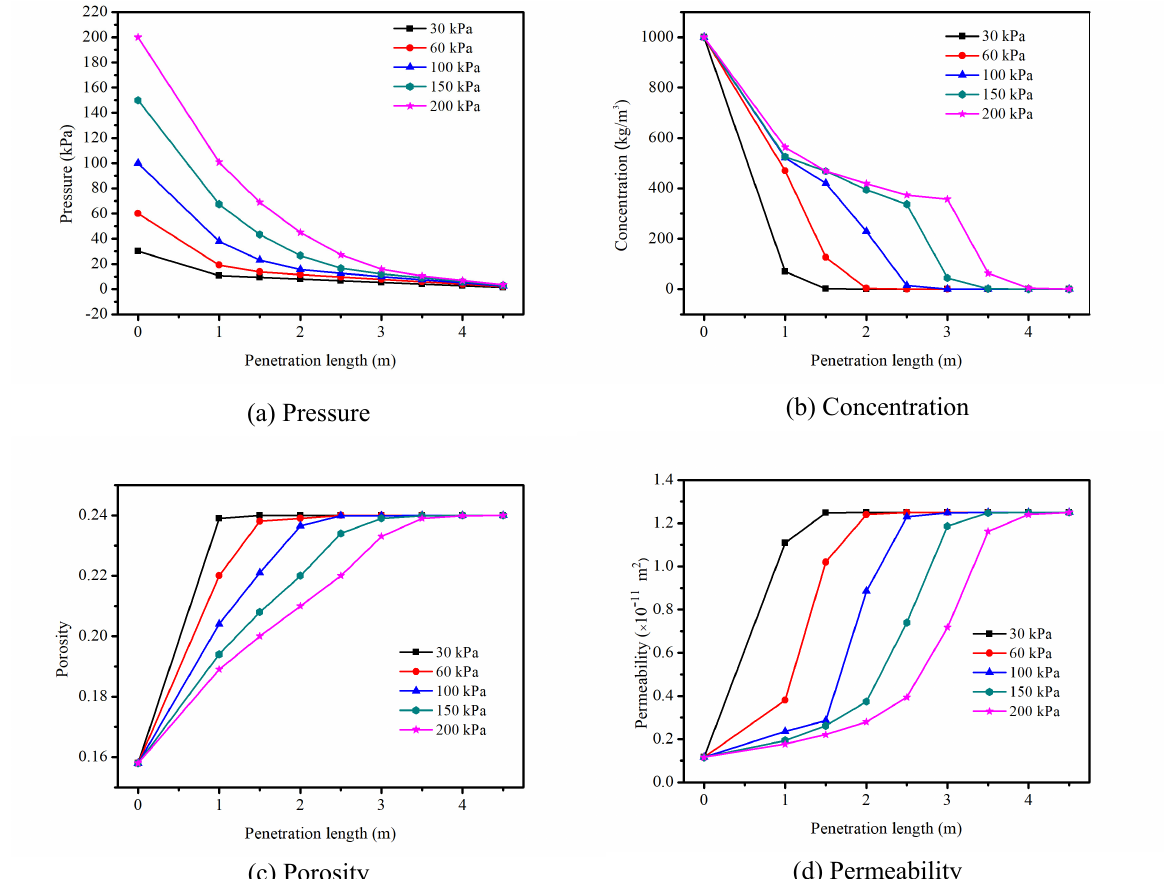
Figure 6. Influences of the injection pressure on the pore pressure, concentration, porosity and